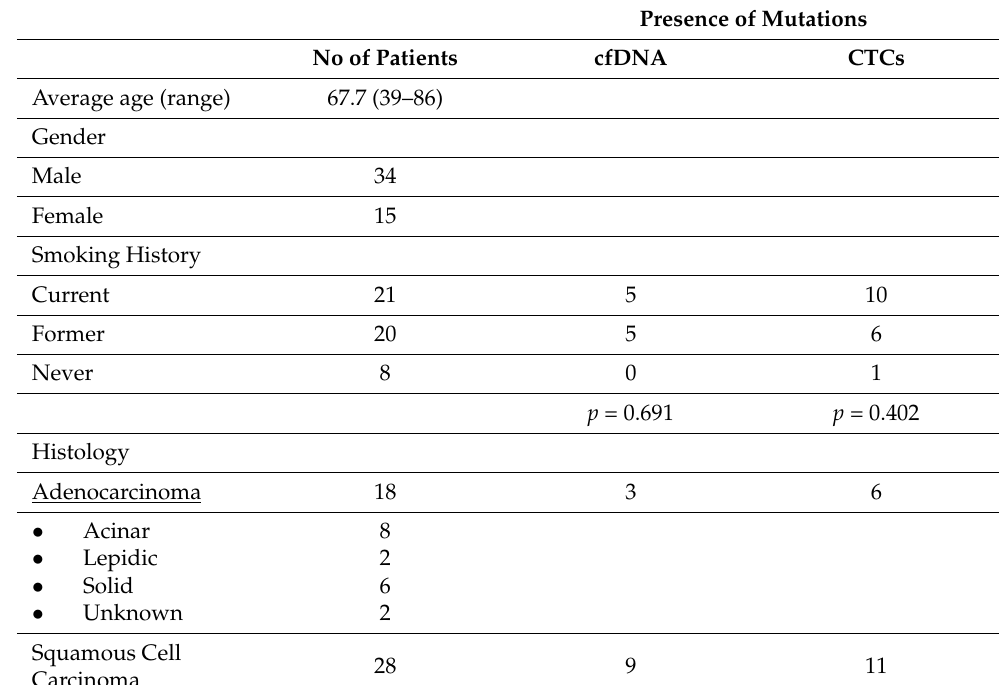
Table 1. Clinicopathological characteristics of patients ( n =